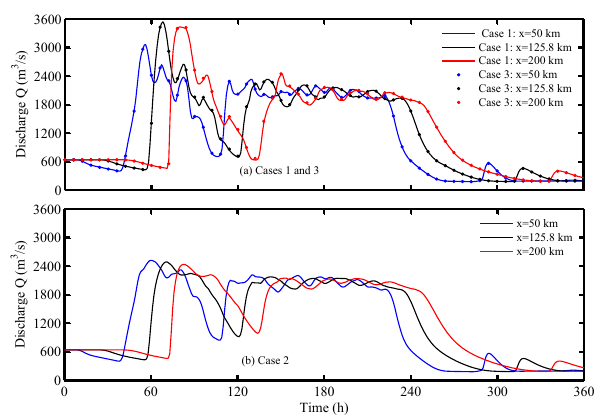
Fig. 1. Discharge hydrographs at distinct locations for (a) Cases 1 and 3, (b) Case 2.